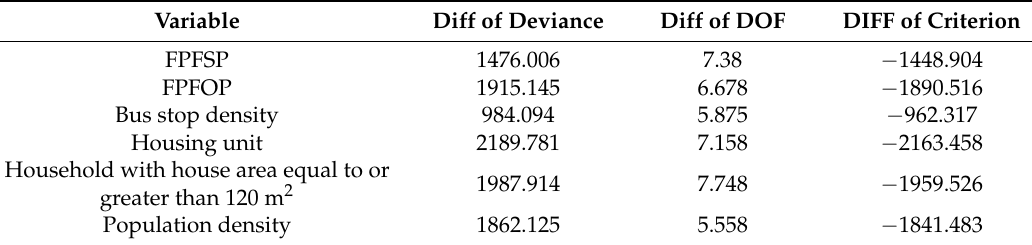
Table 4. Results of testing spatial non-stationarity.